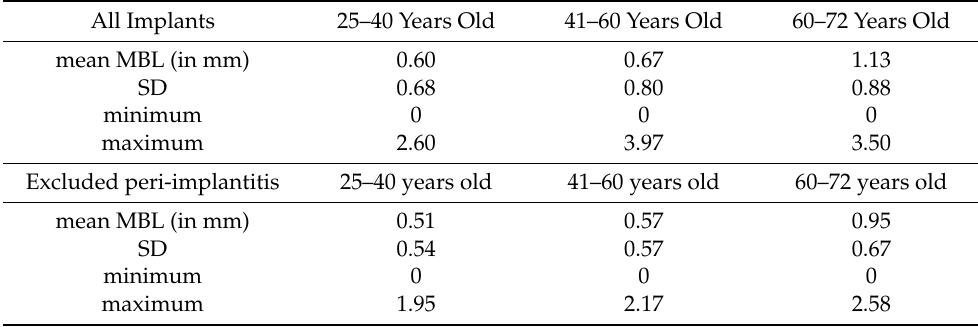
Table 4. Thickness of keratinized tissue (TKT) in studied groups of patients. Data are means ± SD. G1